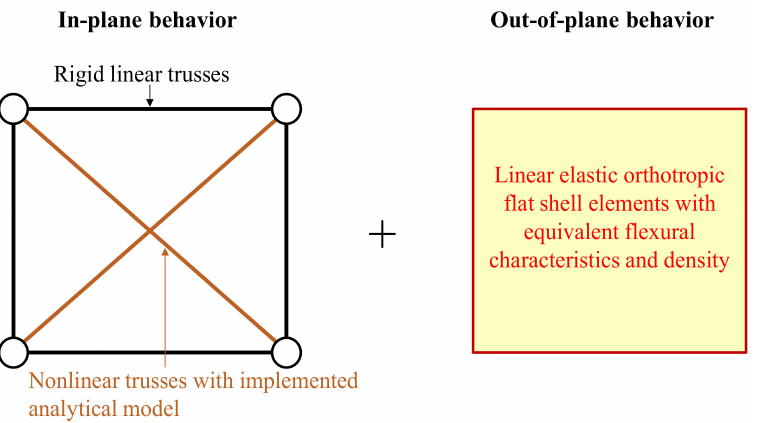
Figure 4. Adopted strategy for modeling in-plane response (macro-elements featuring the imple- mentation of the analytical model presented in Reference [38]) and out-of-plane behaviors (flexural equivalent shell elements) of timber diaphragms (Reprinted from Reference [41]).